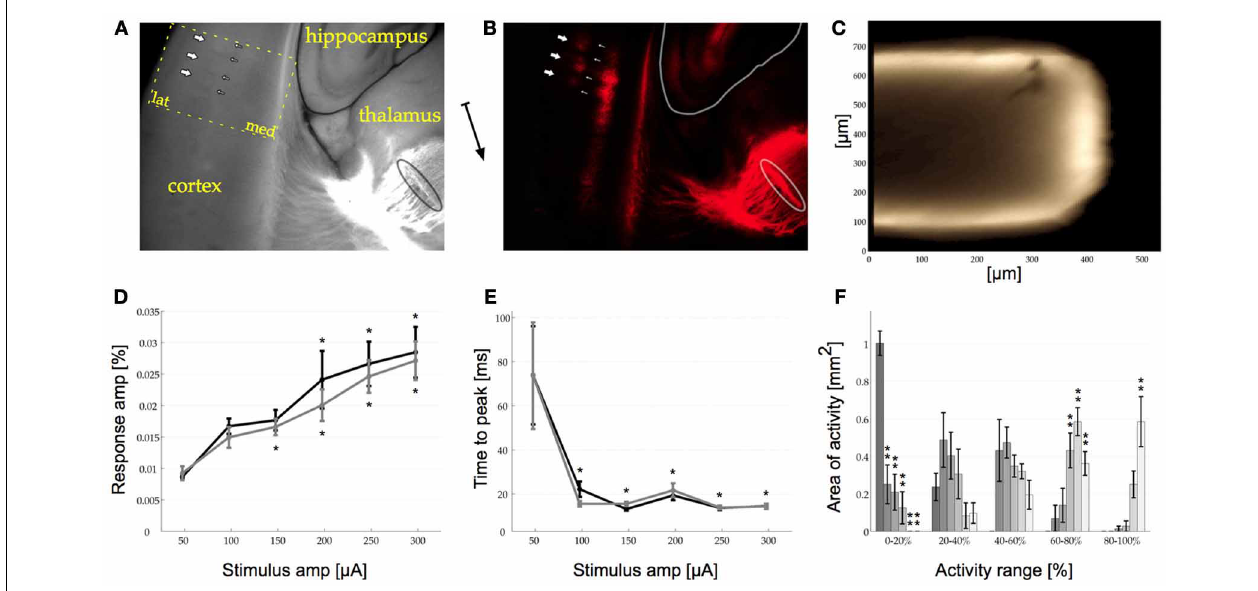
FIGURE 1 | (A) Photo of part of the thalamocortical brain slice including cortex, hippocampus, and thalamus. The dotted outline marks the